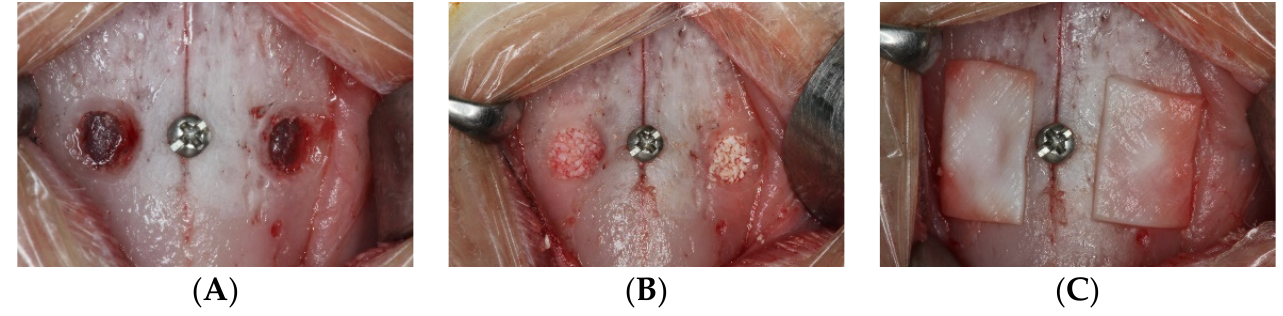
Figure 1. Clinical overview of the surgical procedures: ( A ) antrostomy preparation ( B ), elevated space filled with grafts ( C ), collagen membrane covering the antrostomies.